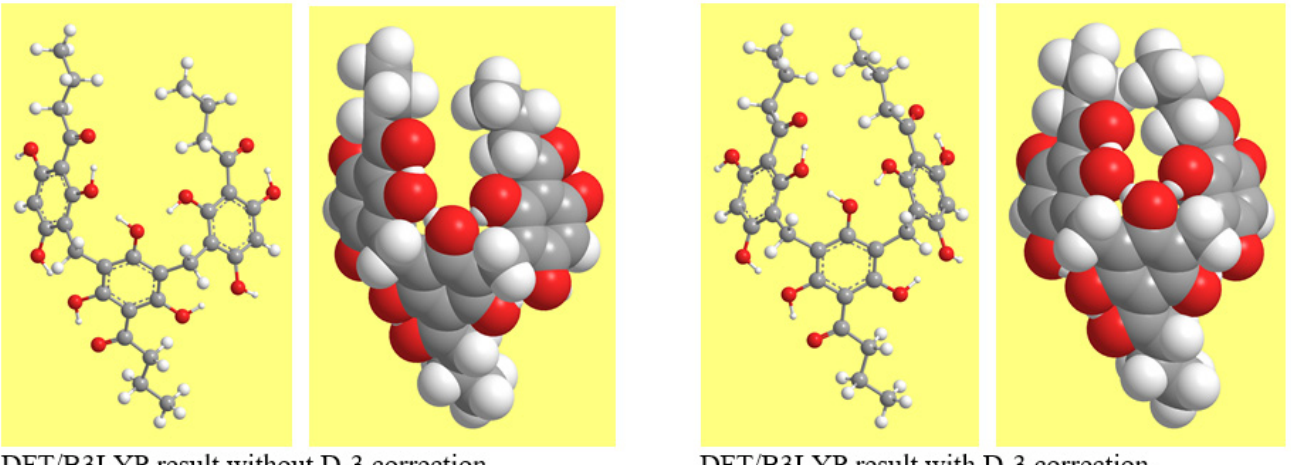
Figure 7. Illustration of the geometry changes in terms of ‘coming closer’ of atoms, resulting from the addition of dispersion correction. The T9-2y conformer is selected as example. Distances referred to the upper rim and not depending on the flexibility of the R and R ″ chains can be considered as realistic indicators of the phenomenon; for instance, the distances C1----C1 ″ , C13----C13 ″ , O8----O12 ″ and O12----O8 ″ respectively have the lengths (Å) 7.477, 7.029, 4.233 and 10.865 in the DFT results and 6.373, 5.487, 3.791 and 9.187 in the DFT-D3 results.